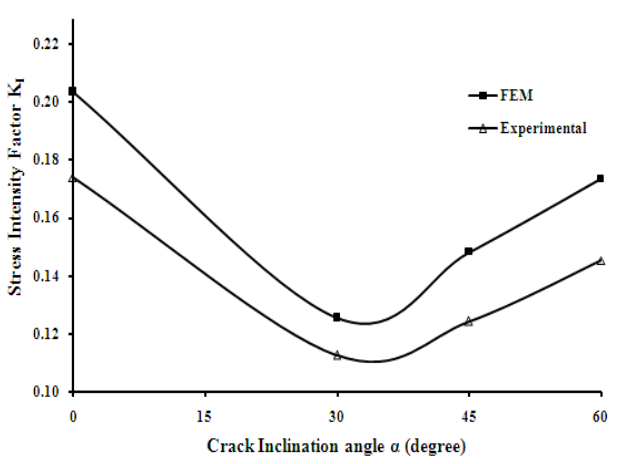
Figure 8: Comparison of stress intensity factor K I for load σ = 1.125N/mm 2 , biaxial load factor = 1 and a/W= 0.06.